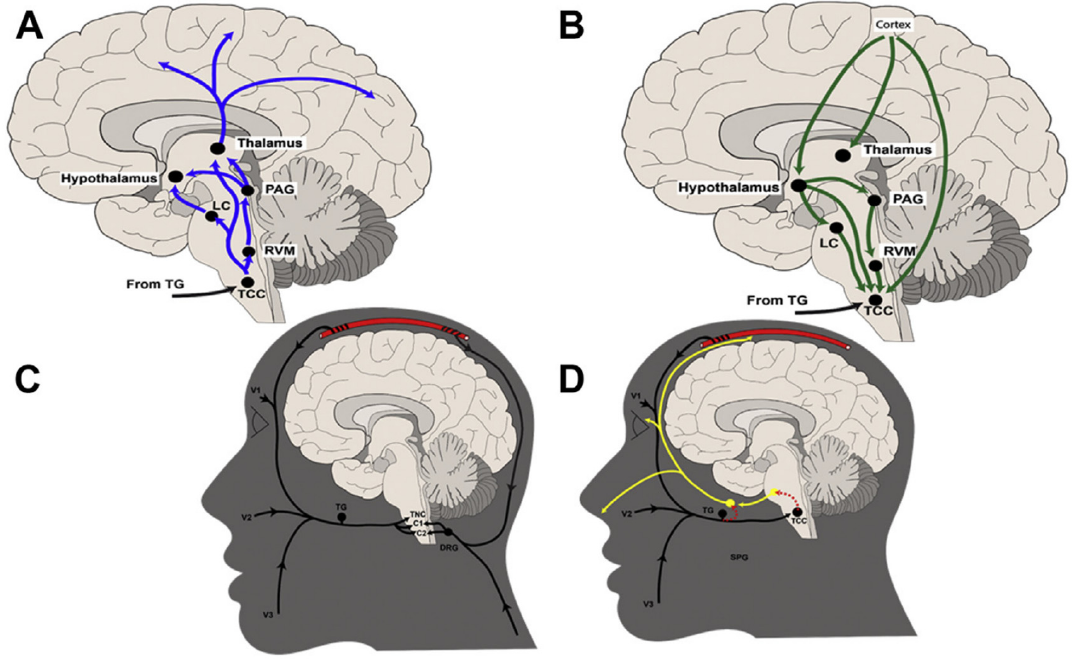
Figure 1. Schematic representation of ascending and descending mechanisms involved in the pathophysiology of migraine, interaction between peripheral and central nervous systems and the trigeminal autonomic reflex. ( A ) Ascending mechanisms; ( B ) Descending mechanisms; ( C ) Connection of dural, cervical and trigeminal inputs in the trigeminocervical complex; ( D ) Potential interfaces between trigeminal and parasympathetic arms of the trigeminal autonomic reflex. Cervical dermatomes (C1, C2); dorsal root ganglia (DRG); locus coeruleus (LC); periaqueductal gray (PAG); sphenopalatine ganglion (SPG); trigeminal ganglion (TG); trigeminocervical complex (TCC) rostral ventromedial medulla (RVM); ophthalmic, maxillary, and mandibular dermatomes of the trigeminal nerve (V1, V2, V3, respectively). Reproduced from Goadsby and Holland 2019 with permission.